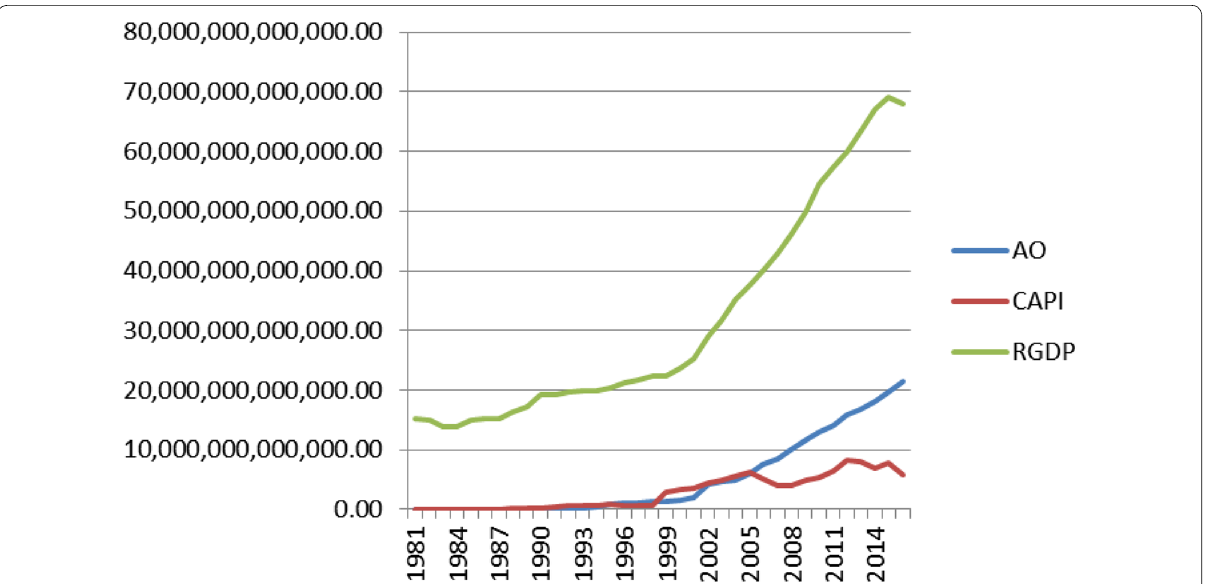
Fig. 1 Trend of capital inflow, agricultural output and growth (Source: Authors’